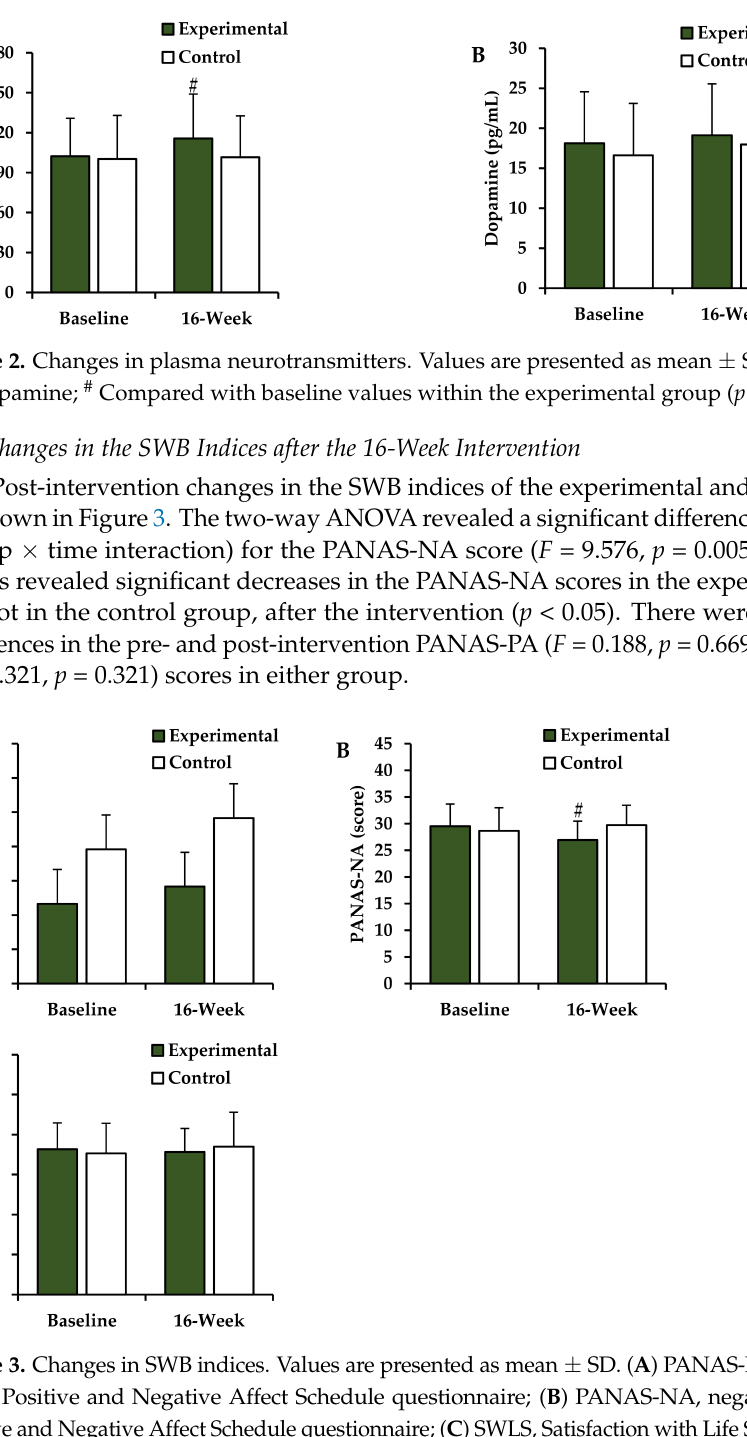
Figure 3. Changes in SWB indices. Values are presented as mean ± SD. ( A ) PANAS-PA, positive affect in the Positive and Negative Affect Schedule questionnaire; ( B ) PANAS-NA, negative affect in the Positive and Negative Affect Schedule questionnaire; ( C ) SWLS, Satisfaction with Life Scale; # Compared with baseline values within the experimental group ( p <